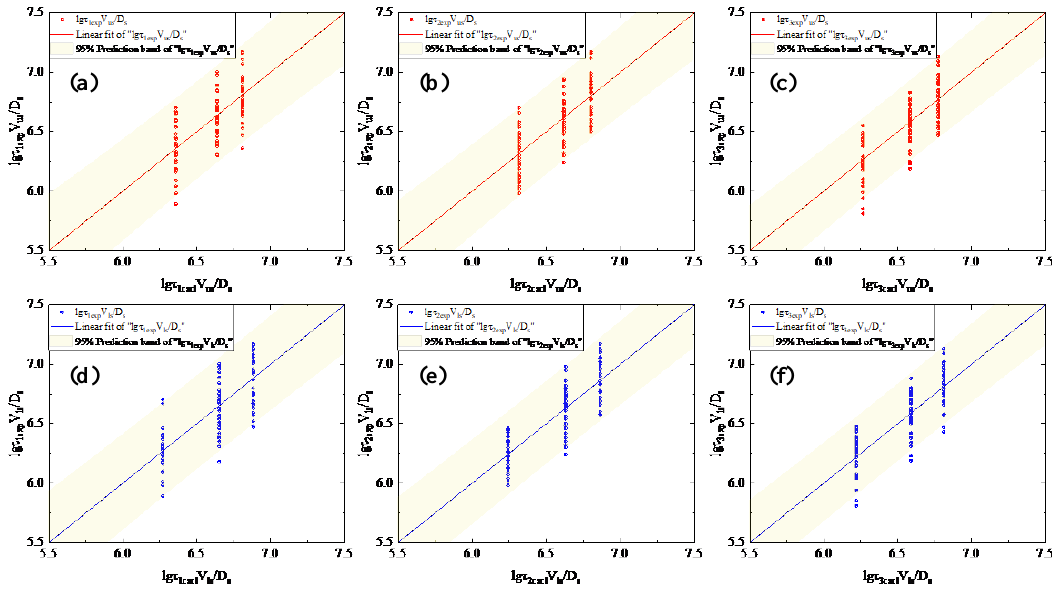
Figure 6. Comparison of experimental lg τ V s / D s with calculated ones for upper side nozzle ( a – c ) and lower side nozzle ( d – f ), respectively, using τ 1 , τ 2 , τ 3 .